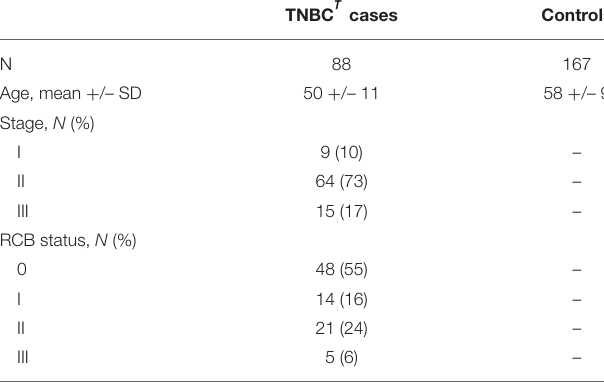
TABLE 1 | Patient and tumor